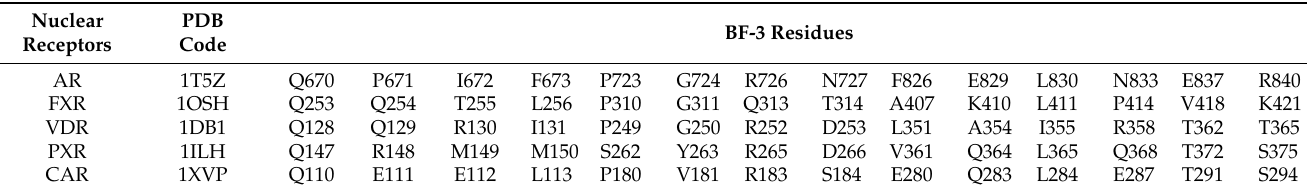
Table 2. BF-3 residues for PXRs, CARs, and VDRs. The residues were obtained using alignment with the AR and FXR sequences in topologically equivalent positions. ARs and FXRs serve as allosteric site control